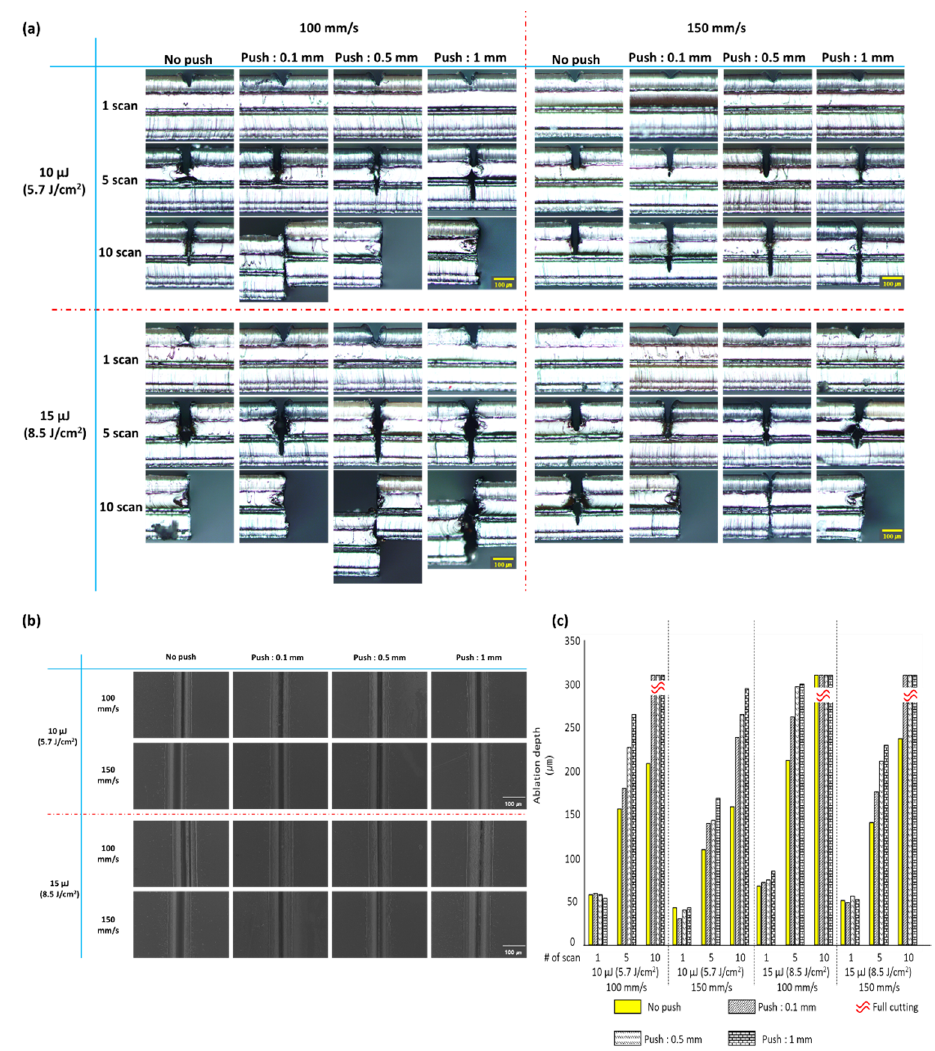
Figure 3. Comparison of the processing results between the conventional laser ablation method and the processing method using a fine curvature generated on the sample in the preliminary preparation in the F-theta lens-based optical system: ( a ) cross-section measurement result observed with an optical microscope, ( b ) FE-SEM images of the surface conditions of the samples processed by the conventional method and by the preliminary preparation after five scans, ( c ) ablation depth measurement results of processing by the conventional method and by the preliminary preparation.